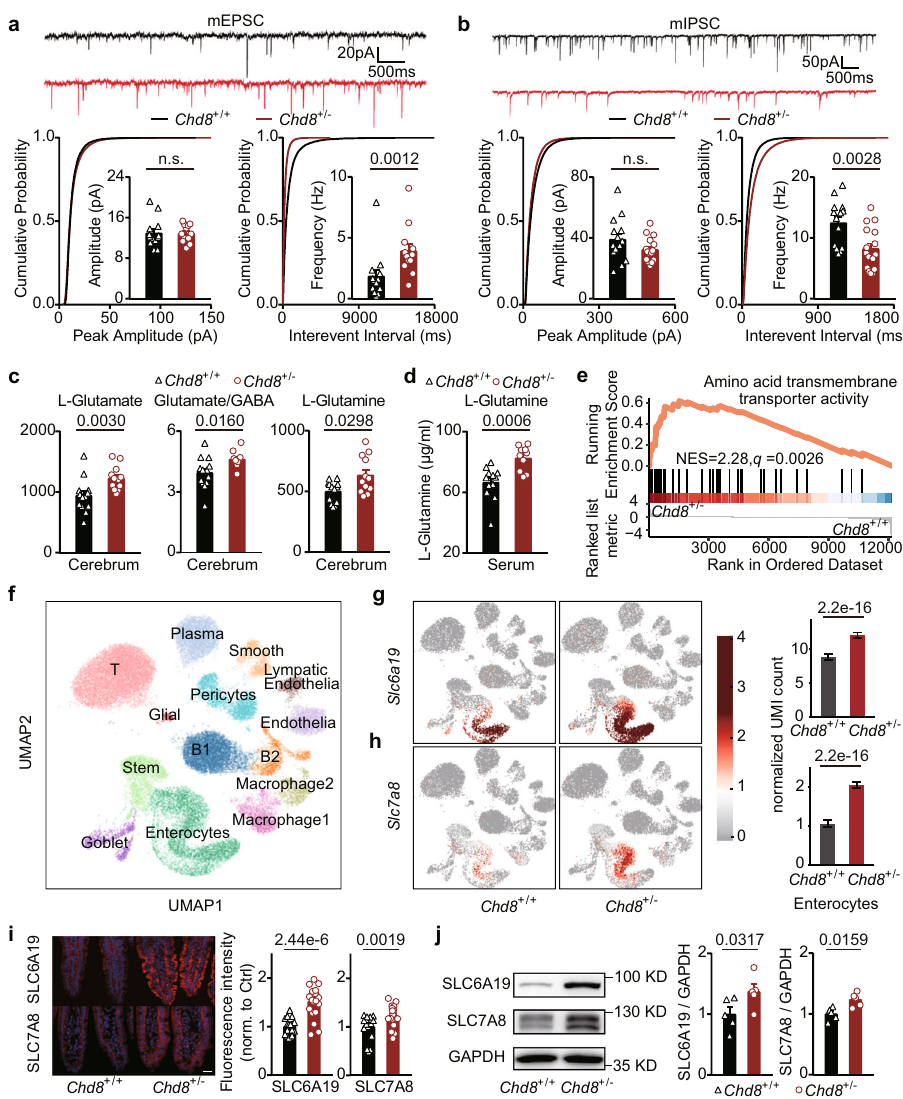
Fig. 2 The E/I imbalance in the Chd8 + / − mice is associated with abnormalities in both the brain and intestine. a , b Representative traces (top), cumulative distribution plots (bottom) and bar graphs (bottom) showing the amplitude and frequency of mEPSCs ( a ) and mIPSCs ( b ) of pyramidal cells in neocortical layer V of adult mice (weeks 8 – 9). n = 3 mice per group. Four to six data points per mouse. n = 13 (mEPSCs/ Chd8 + / + ), 12 (mEPSCs/ Chd8 + / − ), 14 (mIPSCs/ Chd8 + / + ), and 15 (mIPSCs/ Chd8 + / − ) data points, respectively. c Levels of L-glutamate ( μ g/g), glutamate/GABA, and L-glutamine ( μ g/g) in the cerebrum of 12-week-old mice detected by the targeted metabolomics assay. n = 13 and 12 mice, respectively. d Level of L-glutamine ( μ g/ml) in the serum of 12-week-old mice detected by the targeted metabolomics assay. n = 12 and 10 mice, respectively. e GSEA plot showing the enrichment of the amino acid transmembrane transporter activity pathway in small intestinal cells. f UMAP plot of single-cell transcriptome pro fi les of intestines from 12- week-old mice. g , h Highlights of enterocyte cells expressing Slc6a19 ( g ) and Slc7a8 ( h ) in the UMAP plot (left), and comparison of the expression levels of Slc6a19 and Slc7a8 between the Chd8 + / + and Chd8 + / − mice (right) ( n = 4 mice). The bar plots represent the mean of abundance of Slc6a19 (top) and Slc7a8 (bottom) in enterocyte cells ( n = 1527 and 3445 cells in Chd8 + / + and Chd8 + / − mice, respectively). Error bars represent 95% con fi dence interval (CI) of mean value. i Immuno fl uorescence staining of SLC6A19 and SLC7A8 in the ileum of the mice at week 12. Scale bar, 20 μ m. Each symbol represents one image; six to seven images per mouse. n = 17 and 22 symbols, respectively. j Western blotting analysis of SLC6A19 and SLC7A8 protein levels in the small intestine of mice at week 12 ( n = 6 mice). Source data are provided as a Source Data fi le. Quantitative data are shown as the mean ± SEM. Statistical analysis was determined by the two-tailed Mann – Whitney test ( a – d , g – j ). Signi fi cance was indicated by P value ( a – d , g – j ). n.s. means no signi fi cant